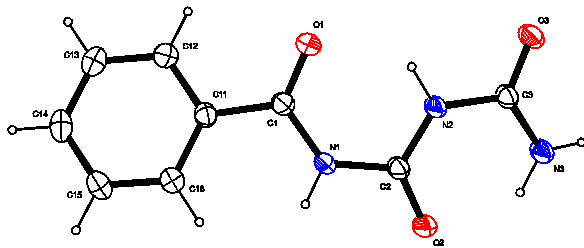
Figure 3: An ORTEP view of 1-((benzamido)formyl) urea ( II ) shows 50% probability displacement ellipsoids and the atom